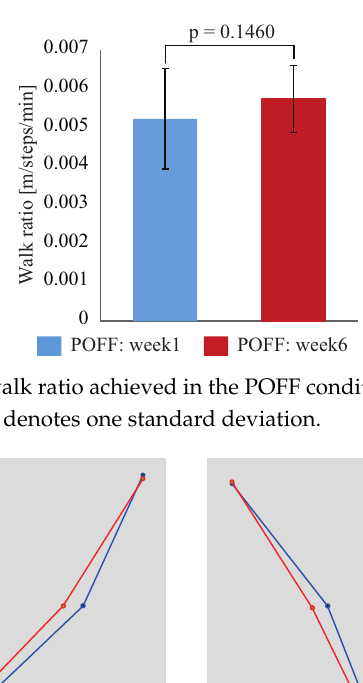
Figure 11. Comparison of the walk ratio of each subject achieved in the POFF condition between Week 1 and Week 6.